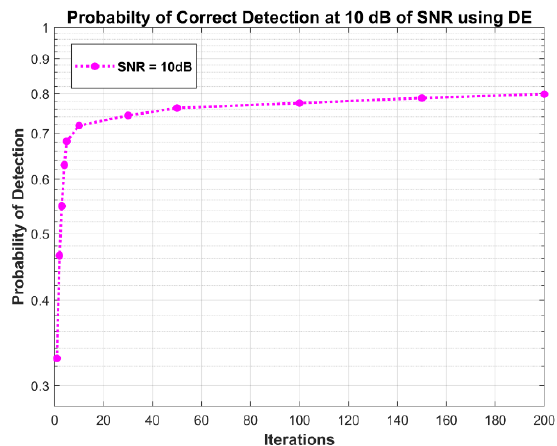
Figure 10. The probability of correct detection with varying iterations at 10 dB SNR.